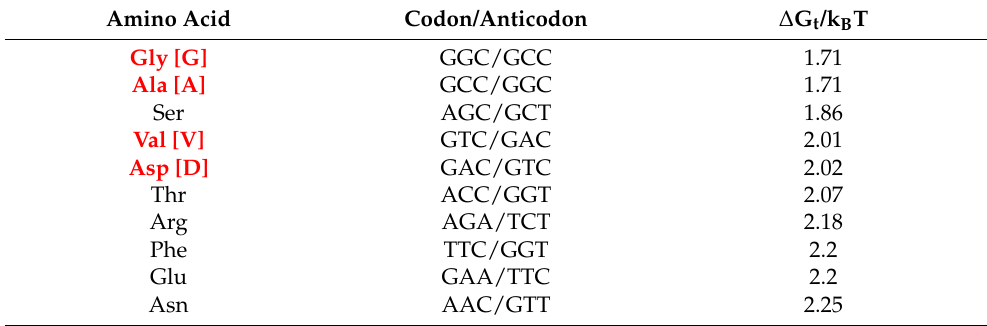
Table 4. Stability of complementary triplets (codon/anticodon). Codons encoding [GADV]-amino acids strongly bind with the respective anticodons except Ser (AGC/GCT). This suggests that stable base pairs could be formed between codon-anticodon even before a chemical modification system had been established. These data are quoted from Taghavi et al.